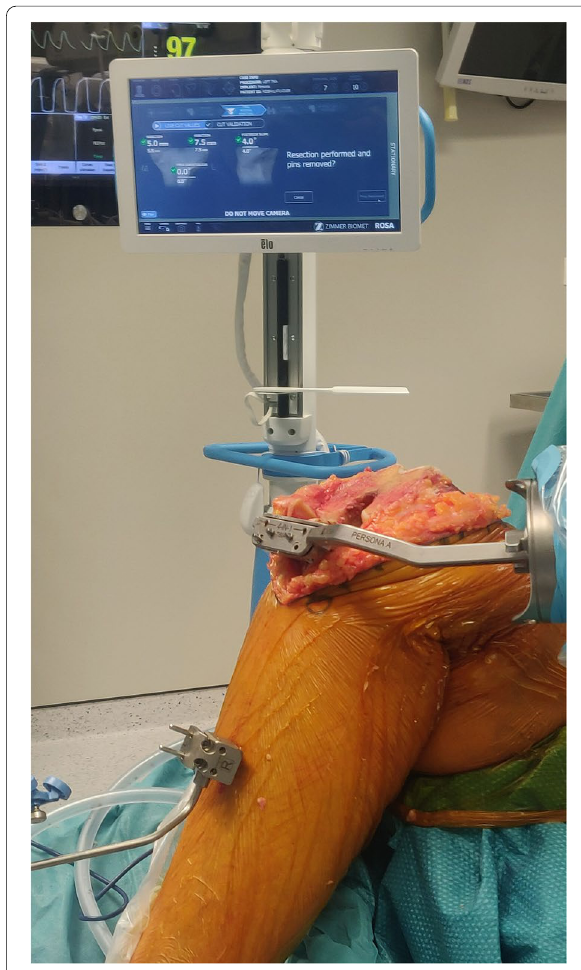
Fig. 3 An intraoperative image demonstrating the cut guide positioned by the robotic